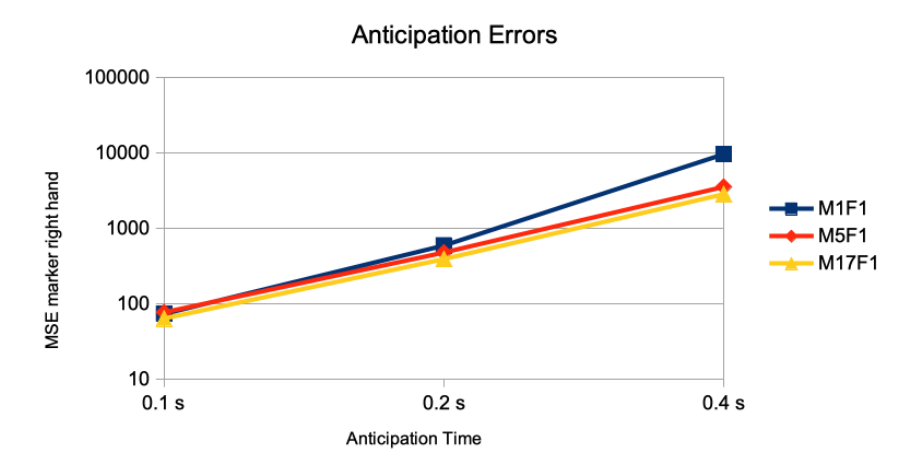
Figure 3. Single marker anticipation without and with spatial context. The anticipation errors of 0.1 s (5 frames), 0.2s (10 frames), and 0.4s (20 frames) are given for the anticipation of marker of the right hand joint using no spatial context (M1F1), all end effector markers and the root position as spatial context (M5F1), and all 17 markers as spatial context (M17F1). The error measure is the average of the mean squared error on the marker sequences of the right hand joint on the different motion classes of the Human 3.6M dataset for actor